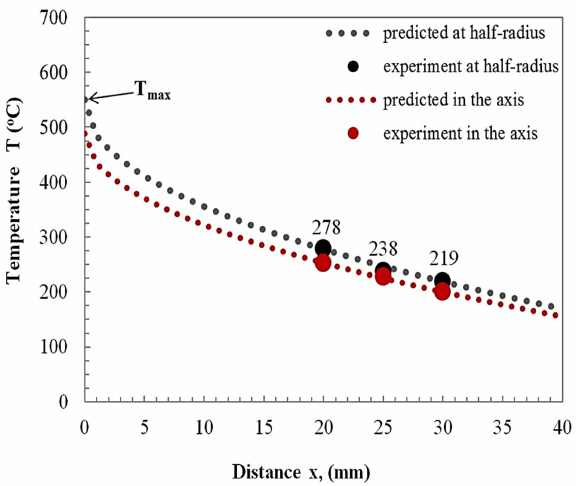
Figure 9. Comparison of the predicted maximum temperature on aluminum alloy side at the weld interface.